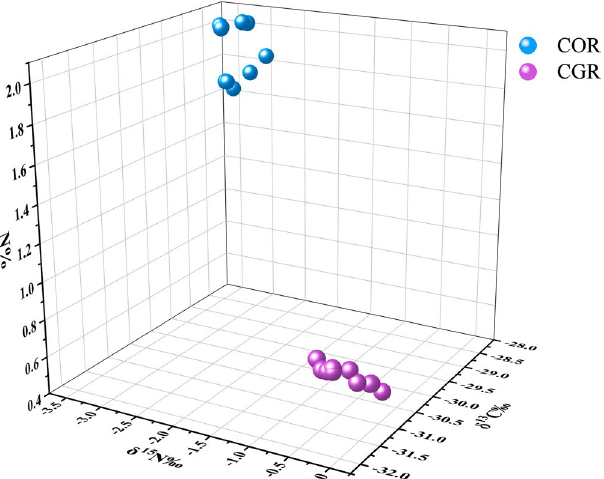
Figure 4. 3D scatter plot of N%, δ 15 N and δ 13 C values in COR and CGR.